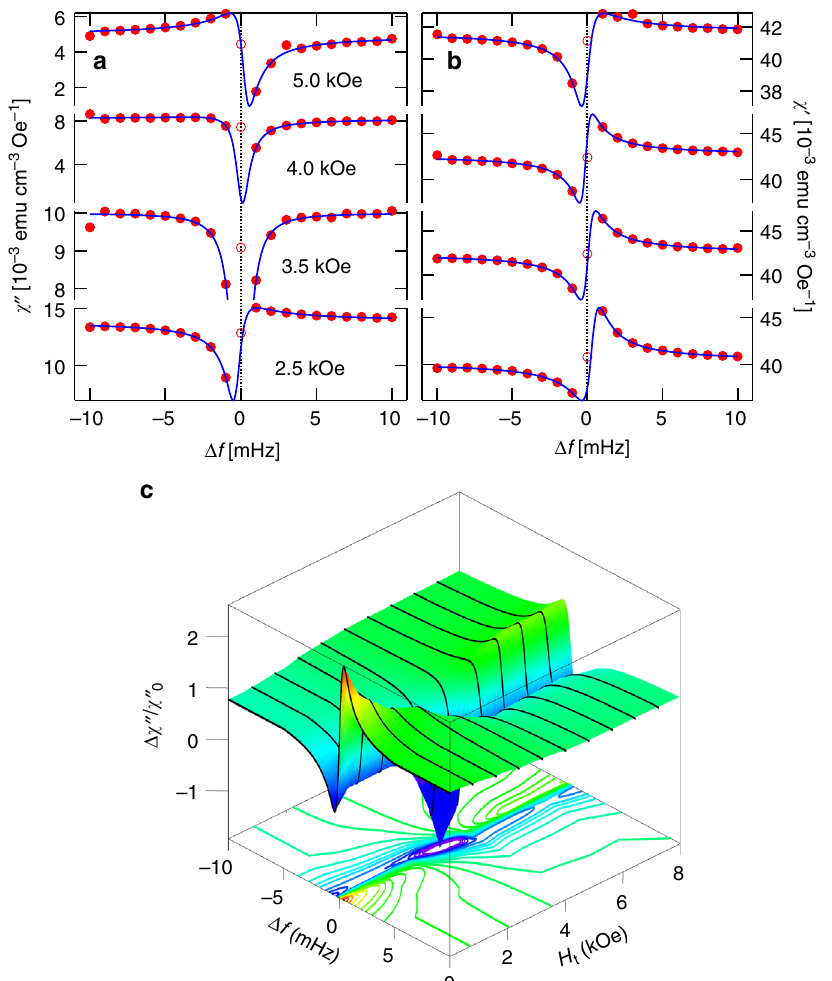
Fig. 4 Linear absorption as a function of transverse fi eld at T = 0.11 K for a 202 Hz pump. a , b Measured imaginary and real susceptibilities (points) and fi ts to a Fano resonance as a function of transverse fi eld for a fi xed 0.3 Oe pump. Transverse- fi eld-induced quantum tunneling tunes the resonant behavior without a corresponding increase in decoherence. c Normalized absorption as a function of frequency and transverse fi eld. Color and z position both indicate normalized